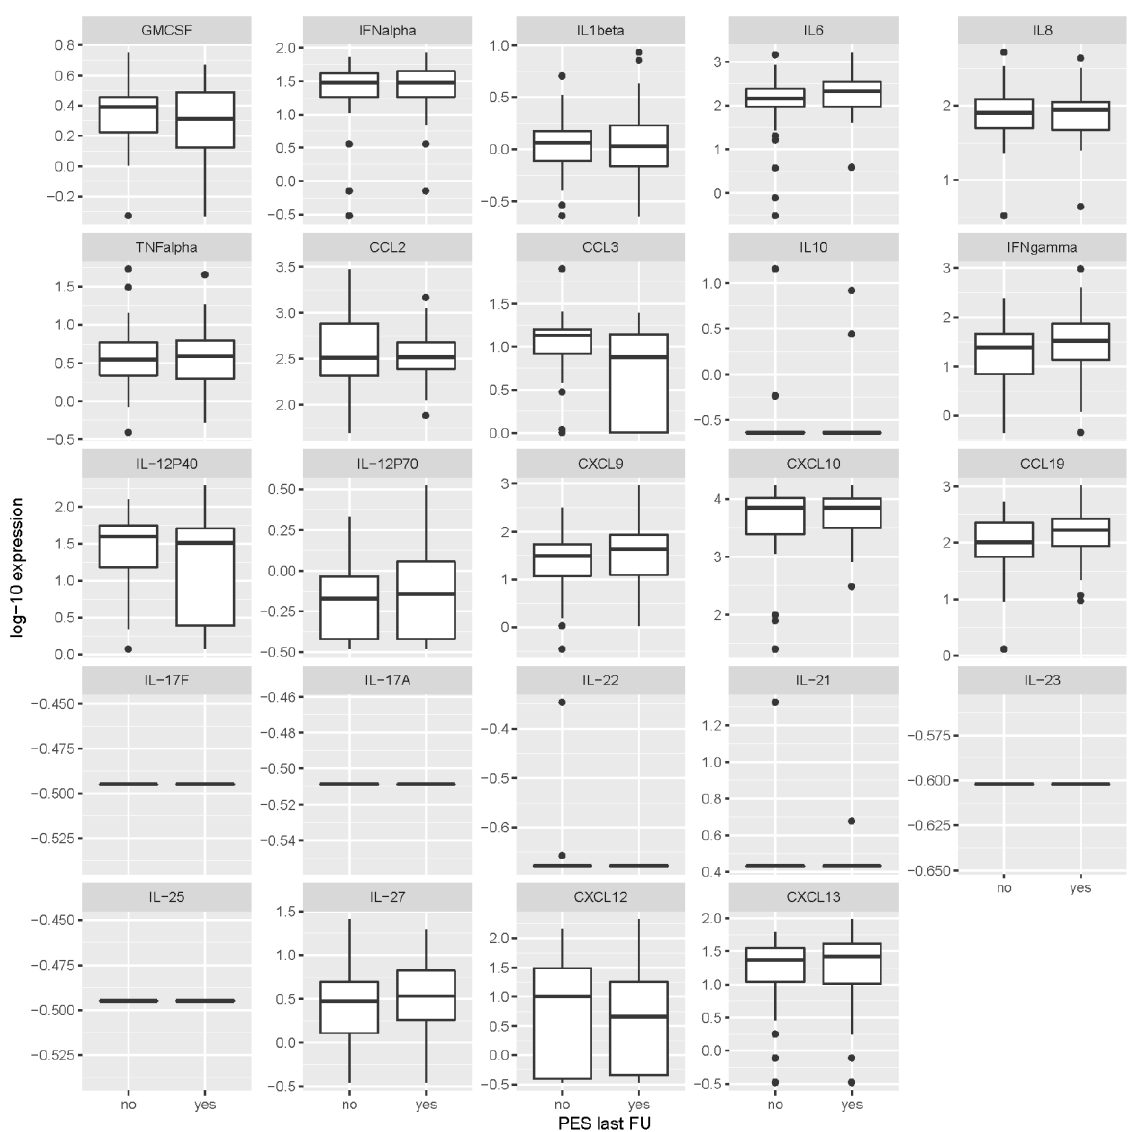
Figure 1. Levels of cytokines / chemokines in cerebrospinal fluid obtained during the meningoencephalitic phase of tick-borne encephalitis according to the presence or absence of post-encephalytic syndrome at the last follow-up visit (2–7 years after acute illness). Concentrations are in ng / mL for IL-17F, IL-23, IL-25 and IL-27, and in pg / mL for all other inflammatory immune mediators. PES last FU = post-encephalitic syndrome present at last follow-up visit.